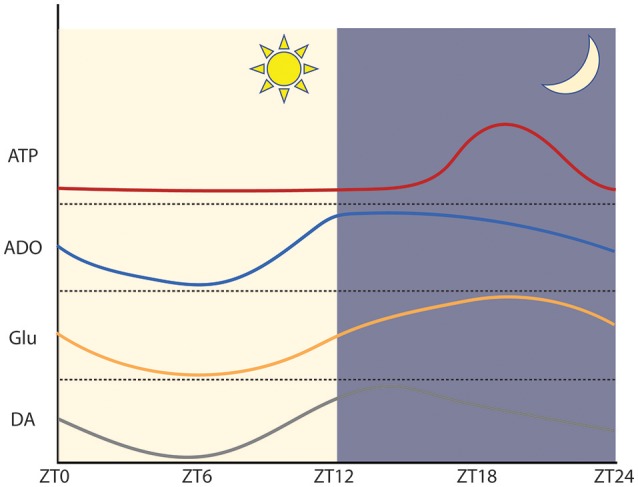
Approximation of the phase and amplitude of circadian neurotransmitter oscillations within regions of abundance in mice. Within the SCN ATP and glutamate peak during the circadian night and reach a trough during the circadian day. In the SCN, adenosine peaks early during the circadian night. Within the dorsal striatum, dopamine peaks early during the circadian night. ATP: adapted from Womac et al. (2009) and Marpegan et al. (2011). Adenosine: adapted from Chagoya de Sánchez (1995). Glutamate: adapted from Brancaccio et al. (2017). Dopamine: adapted from Ferris et al. (2014).